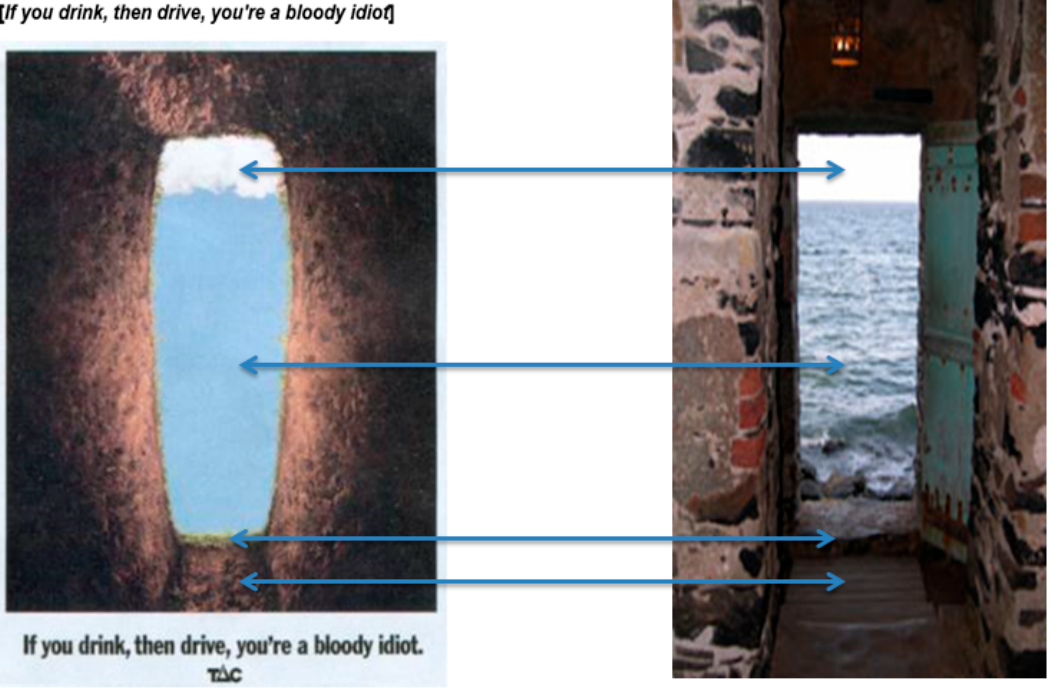
Figure 6. Australian TAC Poster Vs. The Senegalese Door of No Return. Public Service Poster for the Transport Accident Commission (TAC), Australia. Door photo by Willem Proos (courtesy of travelpicturesgallery.com).